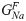
Decreasing GNaF leads to smaller number of spikes but does not change the resting membrane potential.Resting membrane potential as a function of GNaF (a) and number of spikes in response to 500 ms stimulus of varying strengths and different GNaF values (b). Symbols and lines have the same meaning as in Fig (5a) and (5b) respectively except here GNaF is varied instead of GNaL.